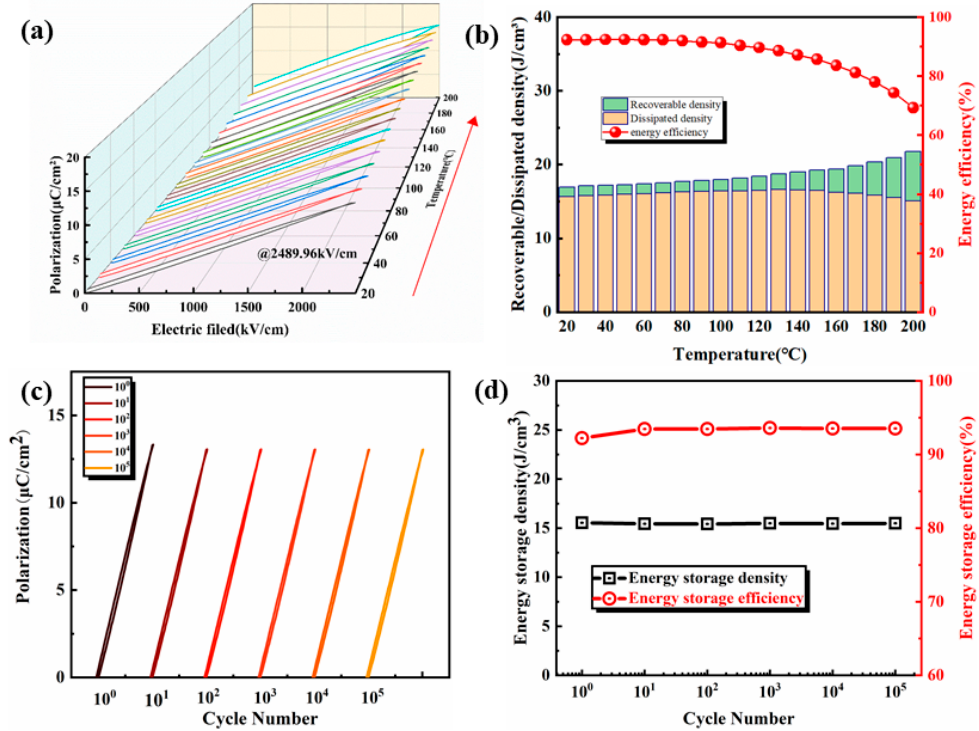
Figure 8. ( a ) At 2489.96 kV/cm, P-E loops of BT-8%Mn film change with the working temperature; ( b ) Energy storage performance with temperature; ( c ) P - E loops change with cycle number of 10 0 –10 5 ; ( d ) Energy storage performance changes with cycle number of 10 0 –10 5 .